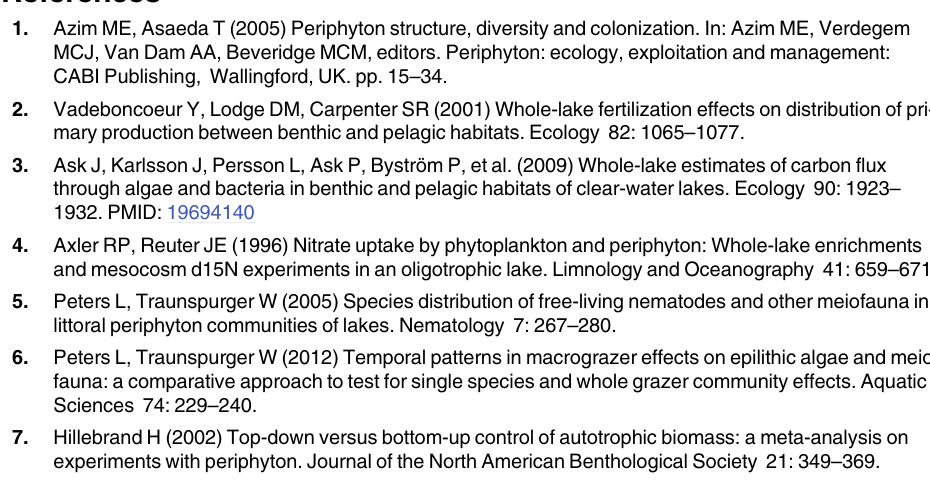
S1 Table. Mean relative abundance (%) and species richness (S) of nematode species in the littoral zone of Lake Erken. Data (n = 5) are given for all treatments (shallow-to-deep: s to d, deep-to-shallow: d to s, shallow-shaded: ss and deep-shaded: ds) at all sampling dates (T0: start, T3: 3 weeks, T6: 6 weeks, and T12: 12 weeks). The feeding types (FTs) were classified fol- lowing the method of Traunspurger [40]: deposit feeder (D), epistrate feeder (E), suction